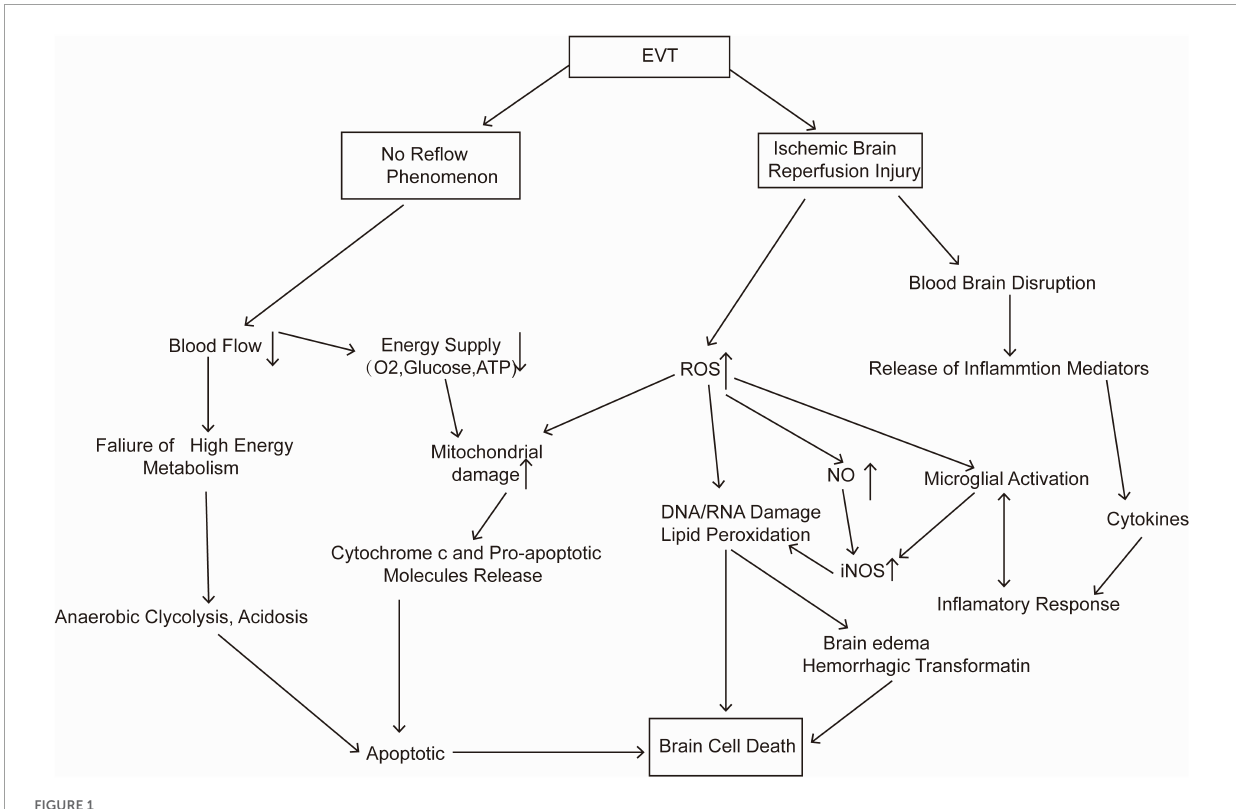
FIGURE1 Pathological changes after endovascular thrombectomy